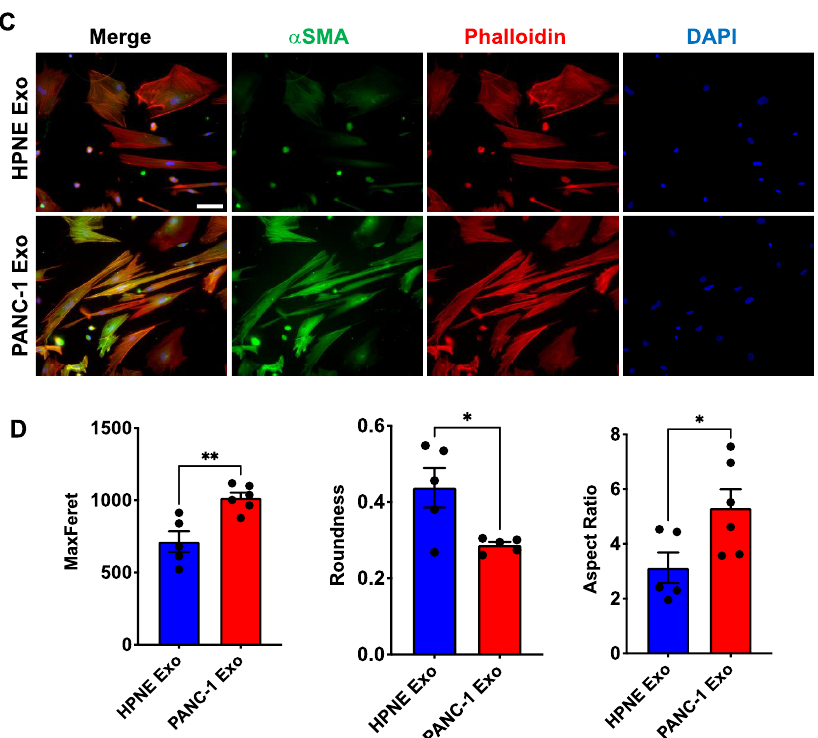
Figure 5. Biomechanical properties of pericytes are significantly influenced by cancer cell-derived exosomes. Force spectroscopy was performed on HPNE Exo- or PANC-1 Exo-treated pericytes (hPC) using AFM. ( A ) Representative AFM images showing the morphological changes in hPC on treatment with exosomes. Scale bar: 20 μm. ( B ) Young’s modulus E and the adhesion force were obtained from the force-distance measurements on the cell surface. Cross-sectional analysis of AFM images was used to measure the cell height after treatment with either HPNE Exo or PANC-1 Exo. ( C ) Representative images of exosome-treated hPC stained with Phalloidin and anti- α SMA Ab. Cells are counterstained with DAPI (blue) to visualize nuclei. Scale bar: 50 µ m. ( D ) Morphological differences were measured by the max Feret, roundness and aspect ratio using ImageJ software. Unpaired two-tailed t -test was used to determine statistical significance and the data are represented as the mean ± SEM. * p < 0.05, ** p < 0.01, **** p <